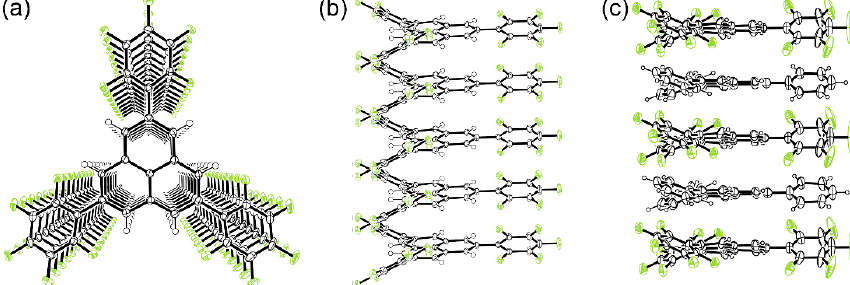
Figure 6. One-dimensional stack of 4 , ( a ) Top view and ( b ) side view. ( c ) Side view of alternating one-dimensional stack of 4 and 5 .